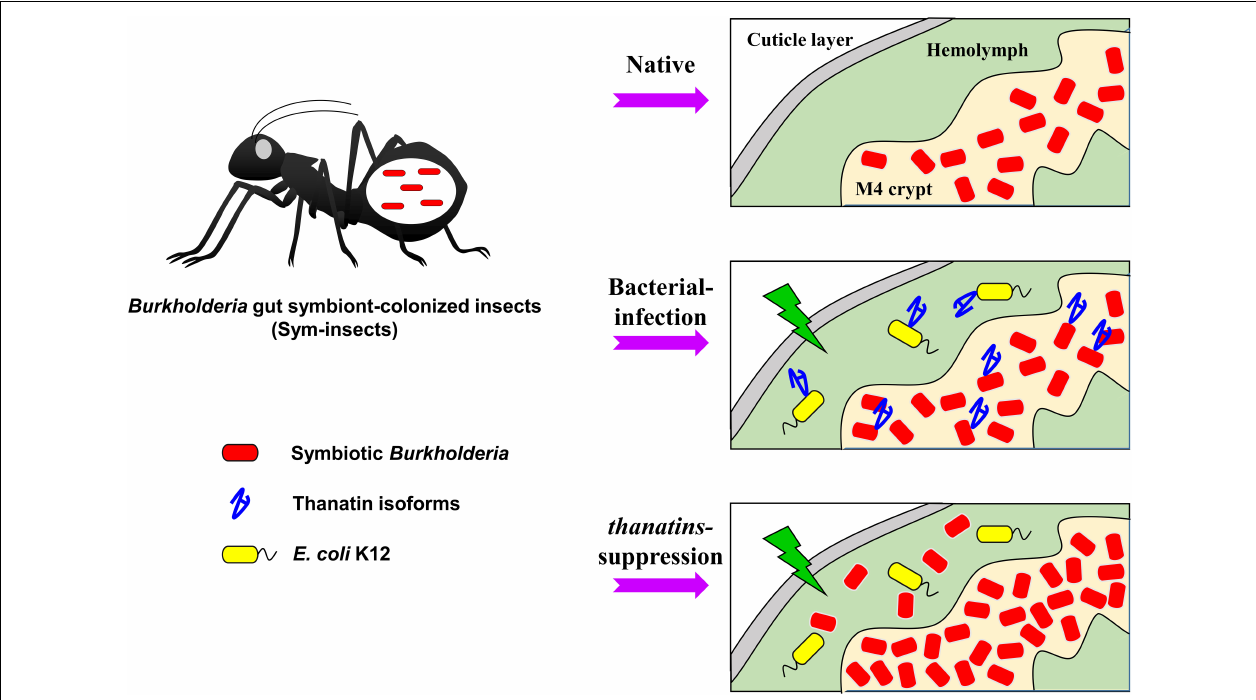
FIGURE 8 | Putative mechanism of action of the thanatin isoforms against Burkholderia gut symbionts during systemic bacterial injection. Thanatin isoforms maintain the gut bacterial population in the M4 crypt during systemic bacterial injection. In contrast, in absence of thanatin ( thanatins RNA i ) and after systemic E. coli K12 injection, overgrown Burkholderia gut symbionts were observed in the hemolymph of the R. pedestris host and exhibited insecticidal